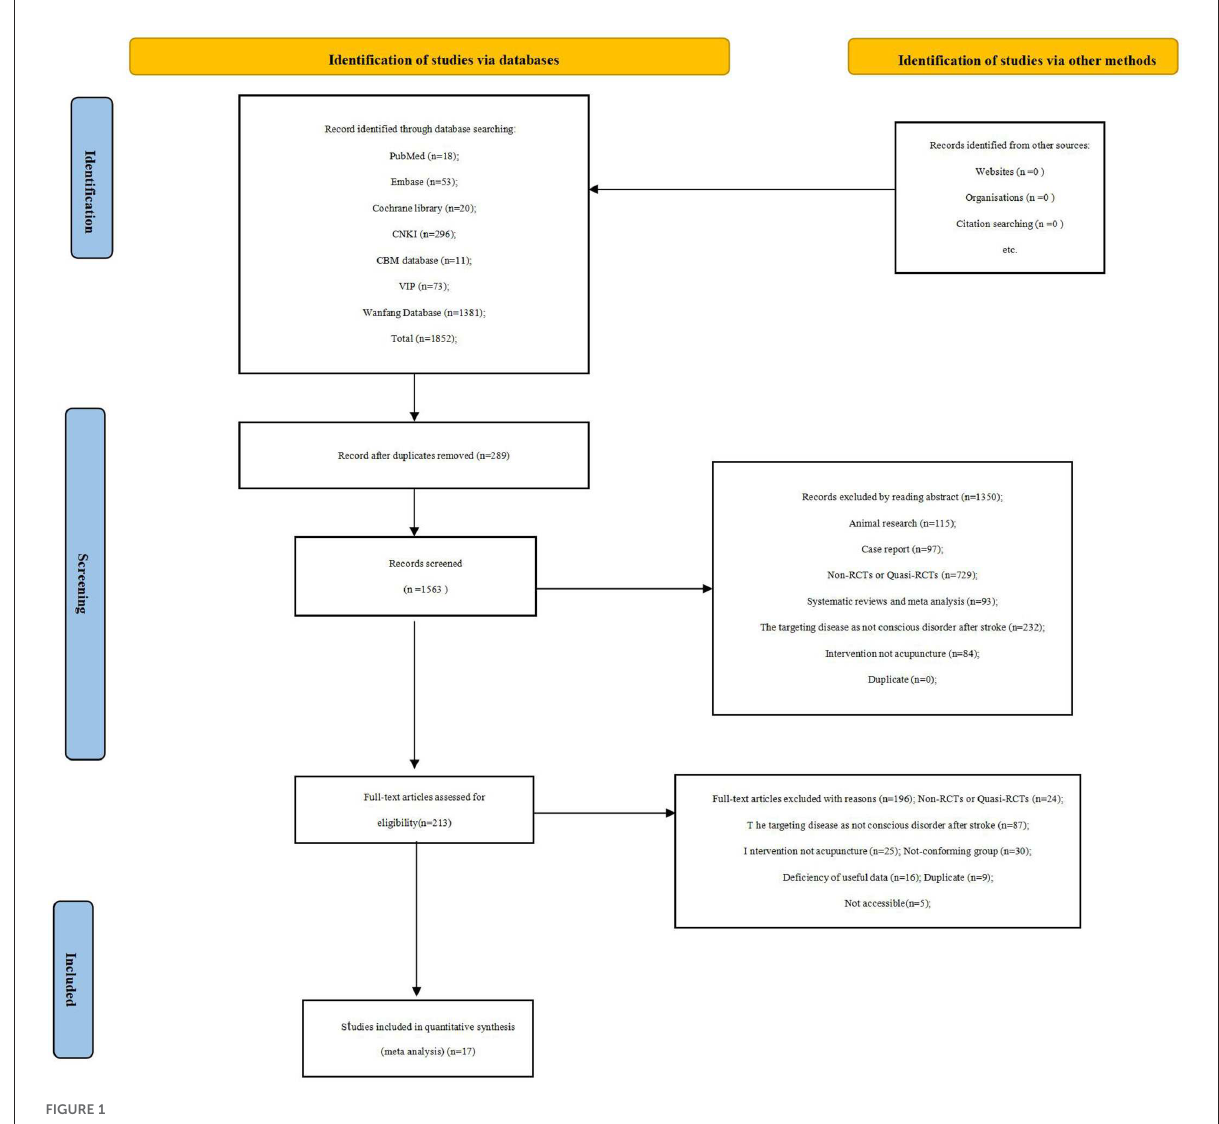
FIGURE1 Study flow